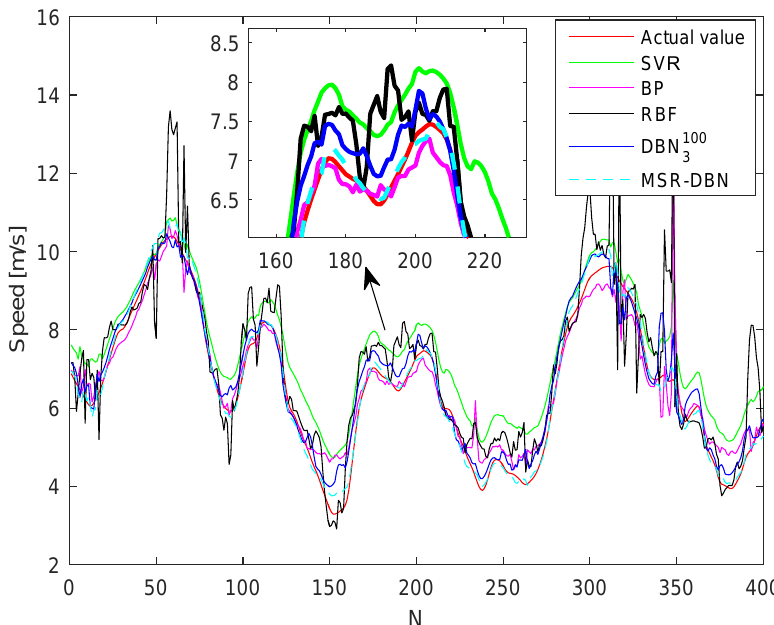
Figure 8. Prediction results of the speed based on different